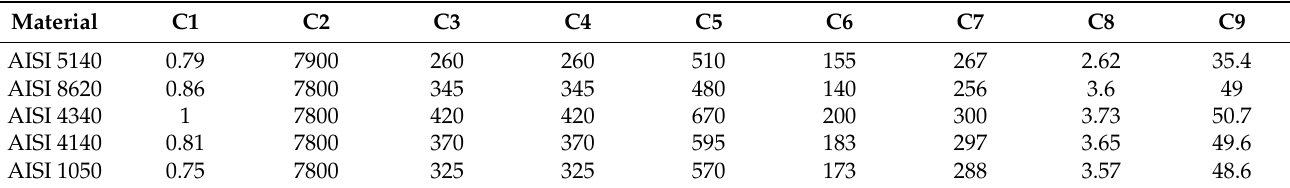
Table 3. Candidate materials’ properties